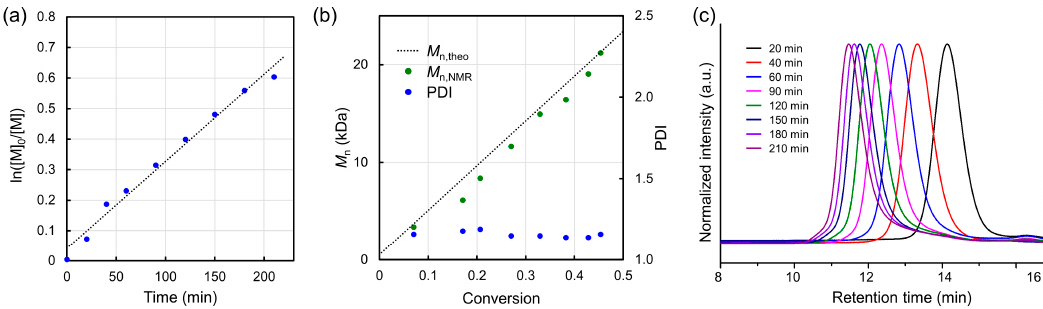
Figure 1. ( a ) Semilogarithmic kinetic plot, ( b ) M n and M w / M n versus conversion, and ( c ) gel